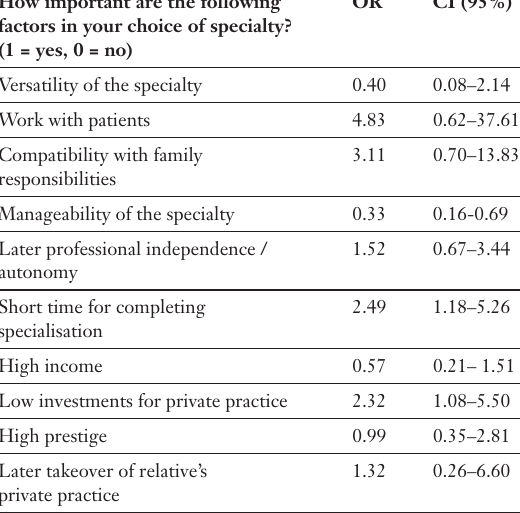
Prediction of the choice of primary care versus other specialties (T 3 ) taking account of the im- portance of career- related factors (T 1 ) (multiple logistic regression, method: